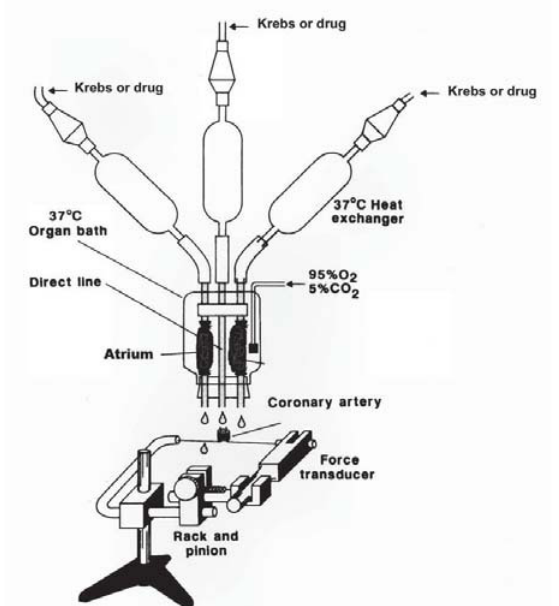
Fig. 1 - Bioassay system from the perfused atrial tube. The atriuns are perfused through a separate constant-flow perfusion loop, and vasoactivity of effluent from the atriuns was bioassayed on a ring of canine coronary artery. The central cannula was used to direct perfusion of coronary rings (physiologic solution with or without drugs). The laterals cannulas was connected to the right and left atrium and the solution perfused thought atrial tubes was dripped on coronary ring. The coronary ring was connected to a force transducer that registers the variation of vascular tone (contraction and relaxation). Modified from Rubanyi et al., 1985 [44]